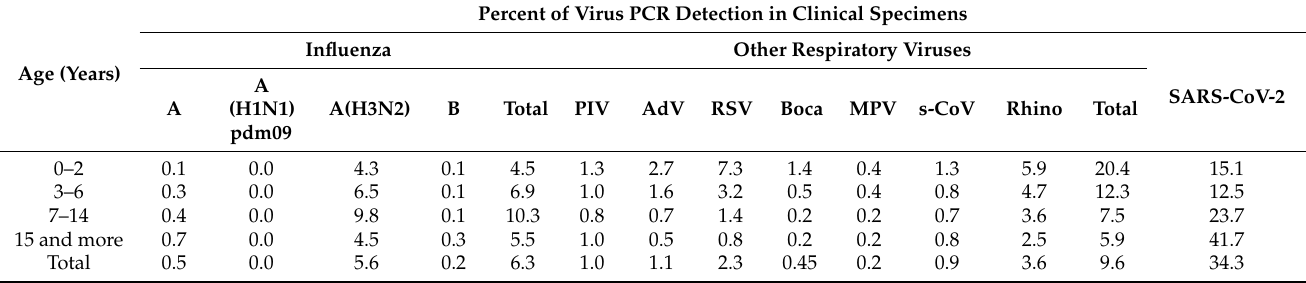
Table 1. Age-specific peculiarities of the etiology of respiratory viral infections according to PCR data under non-sentinel surveillance, season 2021–2022.